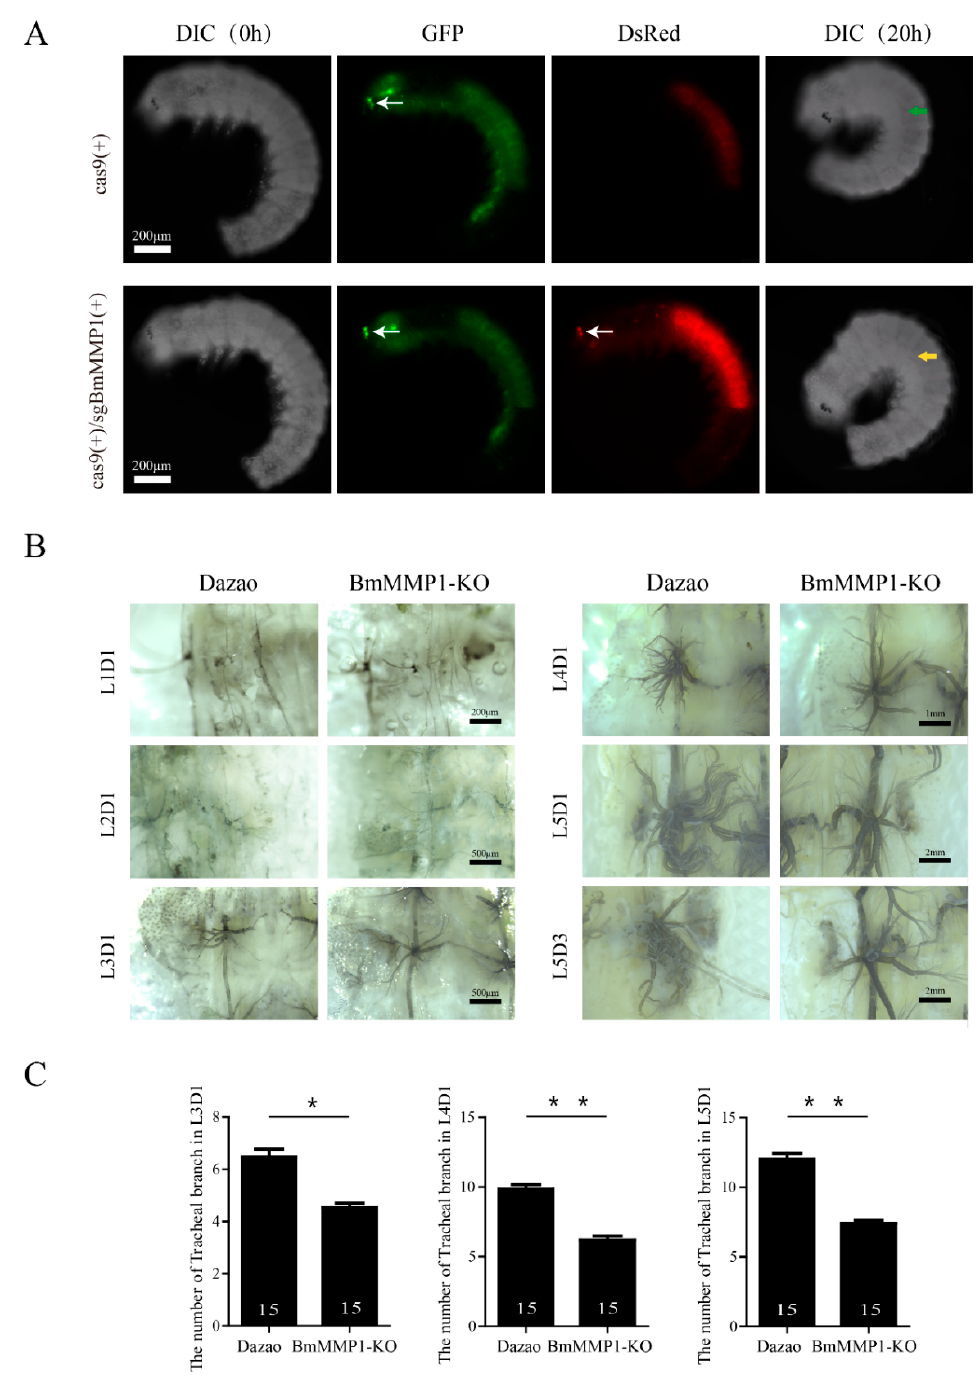
Figure 2. BmMMP1 is required for tracheal branching, but not morphogenesis. ( A ) The embryos of stage 24 imaged by fluorescence microscopy to identify Cas9(+)/sgBmMMP1(+) and Cas9(+) as control. DIC (0 h) represents observed at 0 h in video 1 and 2, DIC (20 h) represents observed at 20 h in video 1 and 2. White arrows indicate the fluorescence of embryo eyes. The green arrow indicated the trachea of control, and the yellow arrows indicated the trachea of mutant. ( B ) The development of trachea in the larval stages was observed under an optical microscope. L1D1–L5D3, first day of the first larval instar to the third day of the fifth larval instar. ( C ) Numbers of tracheal branches in first day of third larval instar (L3D1), first day of fourth larval instar (L4D1) and first day of fifth larval instar (L5D1). n = 15. (*, 0.01 ≤ p < 0.05; * *, p < 0.01).